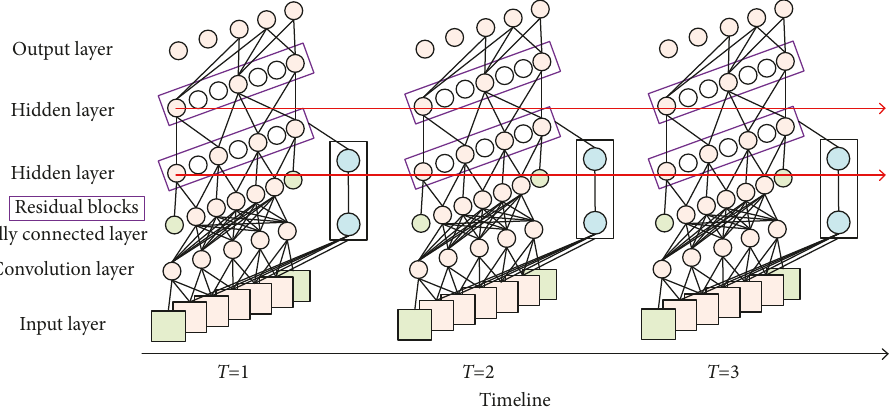
Figure 3: TCN_LSTM network structure.